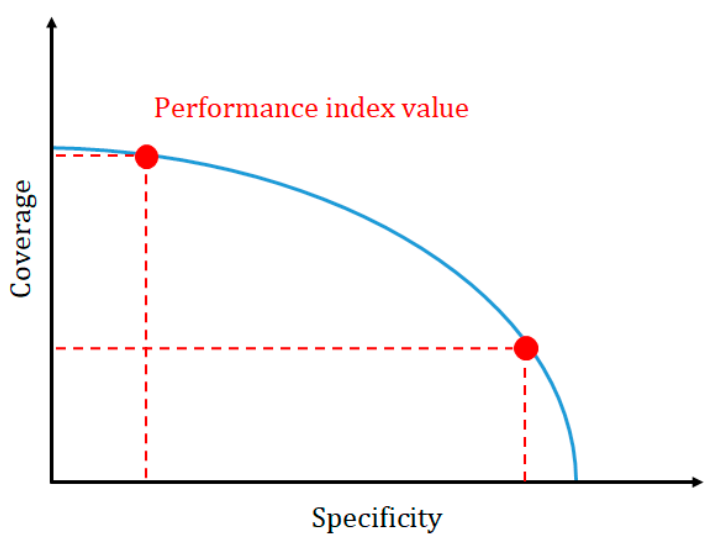
Figure 9. Relation between coverage and specificity.